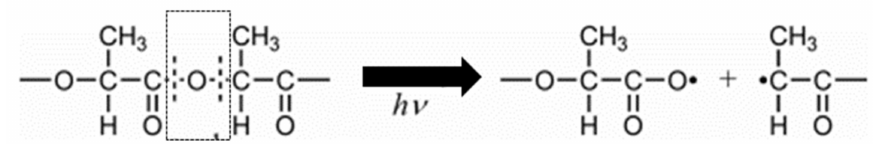
Figure 9. Mc Neil and Leiper mechanism adapted from [157].